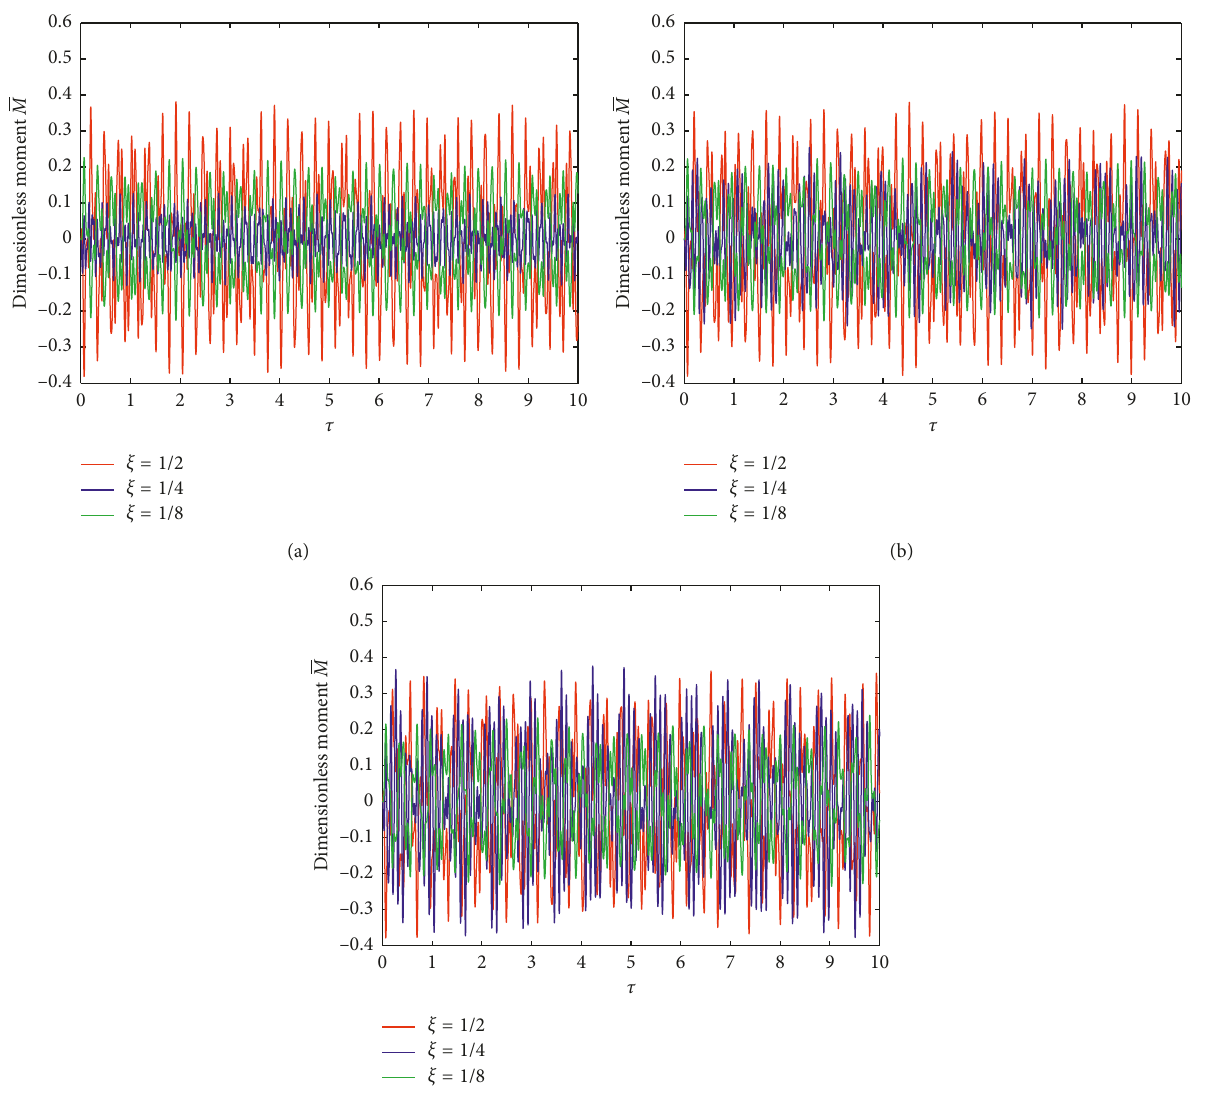
Figure 20: History curves of bending moment on the clamped-clamped pipe with different fluid velocities at different locations: (a) u � 0; (b) u � 1; (c) u �